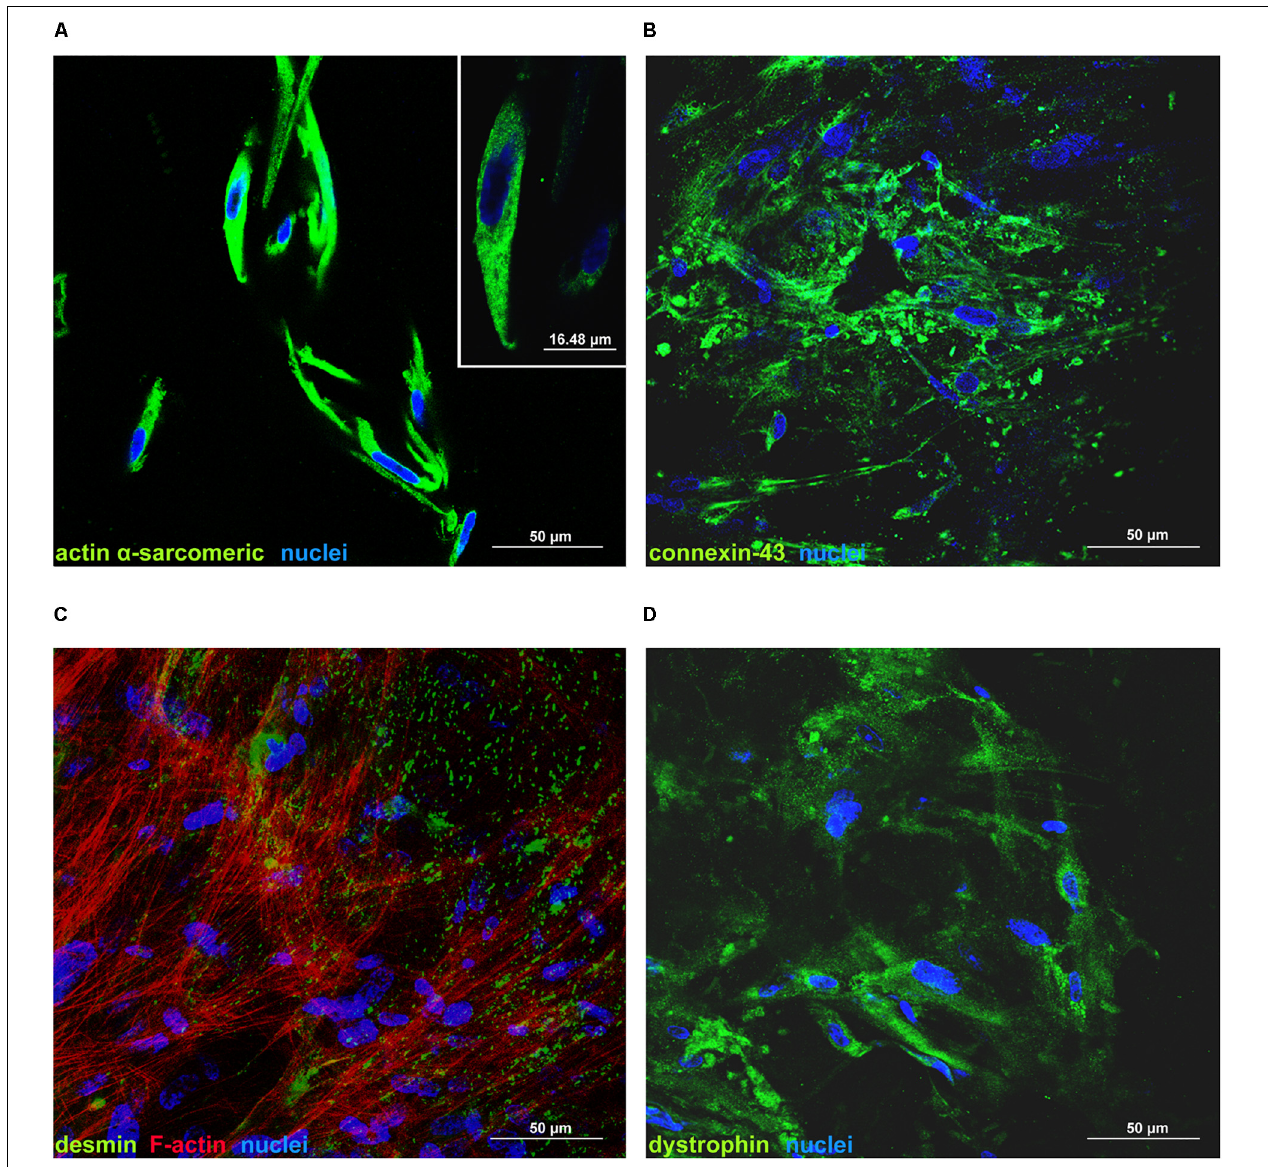
FIGURE 10 | Immunofluorescence analysis of the expression of cardiac myocyte markers by hCPCs cultured on d-HuSk for 4 weeks. Representative images of confocal microscopy analyses showing the immunopositivity and distribution of alpha-sarcomeric actin (A) , connexin-43 (B) , desmin along with F-actin (C) , and dystrophin (D) in hCPCs cultured on d-HuSk. The inset in (A) shows at higher magnification the expression of alpha-sarcomeric actin. (Scale bar: 50 µ m in all pictures, 16.48 µ m in the inset).